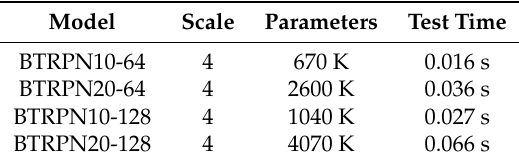
Table 4. Test time of different BTRPN